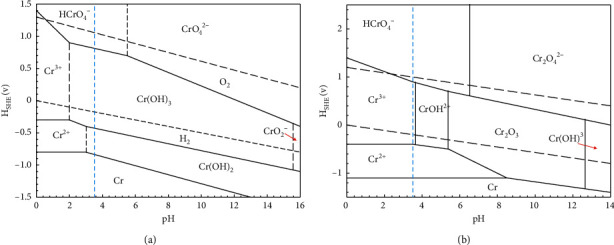
Pourbaix diagrams of Cr with (a) pH2S-free and (b) pH2S-containing conditions in aqueous at T = 25°C [22, 23].